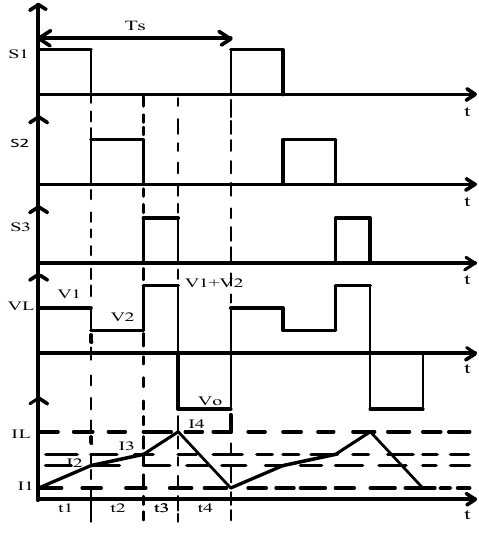
Figure 5. Analytical wave form of the switching signal, inductor voltage and current, respectively.